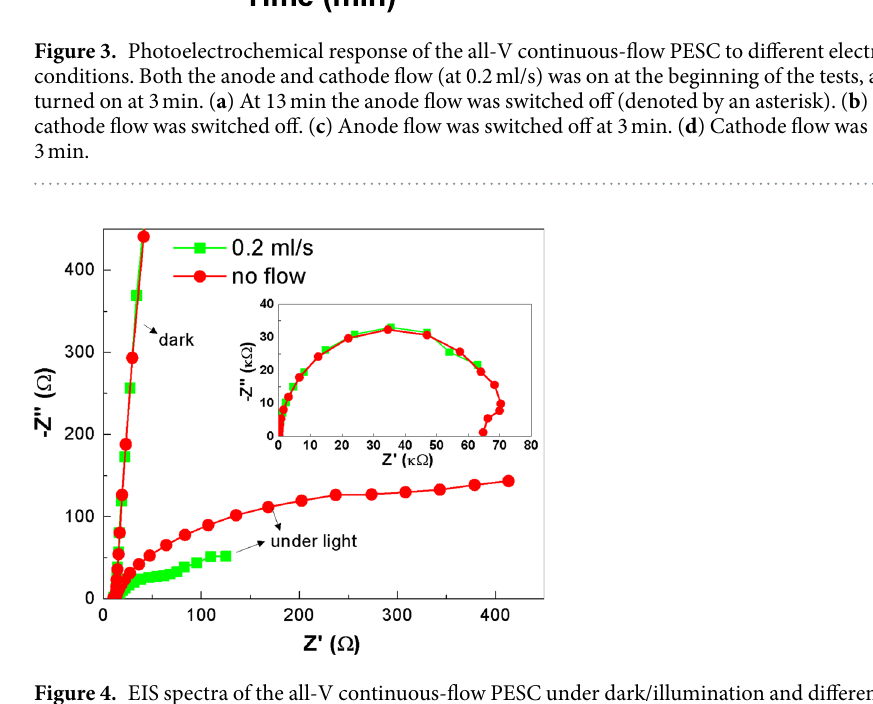
Figure 4. EIS spectra of the all-V continuous-flow PESC under dark/illumination and different flow conditions using 0.01 M vanadium redox species. The inset shows the full spectra under